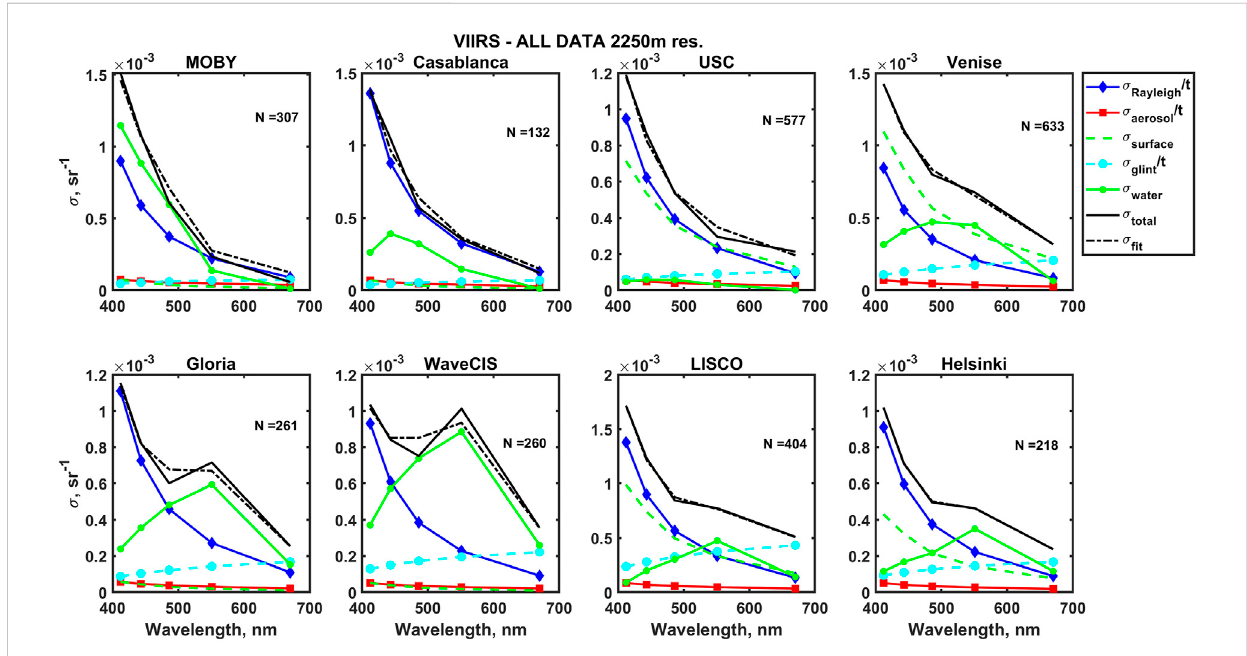
FIGURE 5 Results of fi tting for VIIRS same stations. Total uncertainty is the solid black line and the fi tted curve is dashed black line.